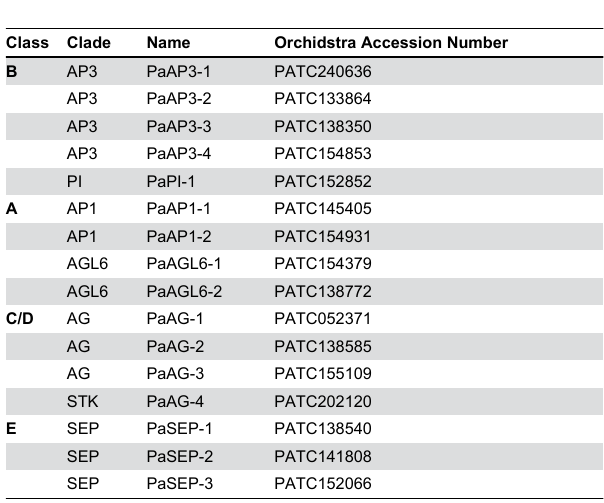
Table 1. ABCDE Functional Classes of MADS-Box Genes in Phalaenopsis aphrodite